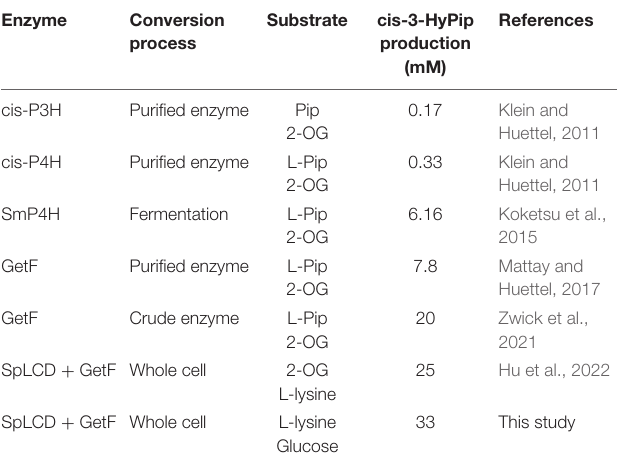
FIGURE 6 | The time course of the bioconversion by strain 15 [ E. coli BL21(DE3) (cid:77) sucA (cid:77) aceA pETduet-1-29- getf -RBS(T7)- splcd &pCDF- glta - icd ]. TABLE 1 | Currently used biological methods for the production of